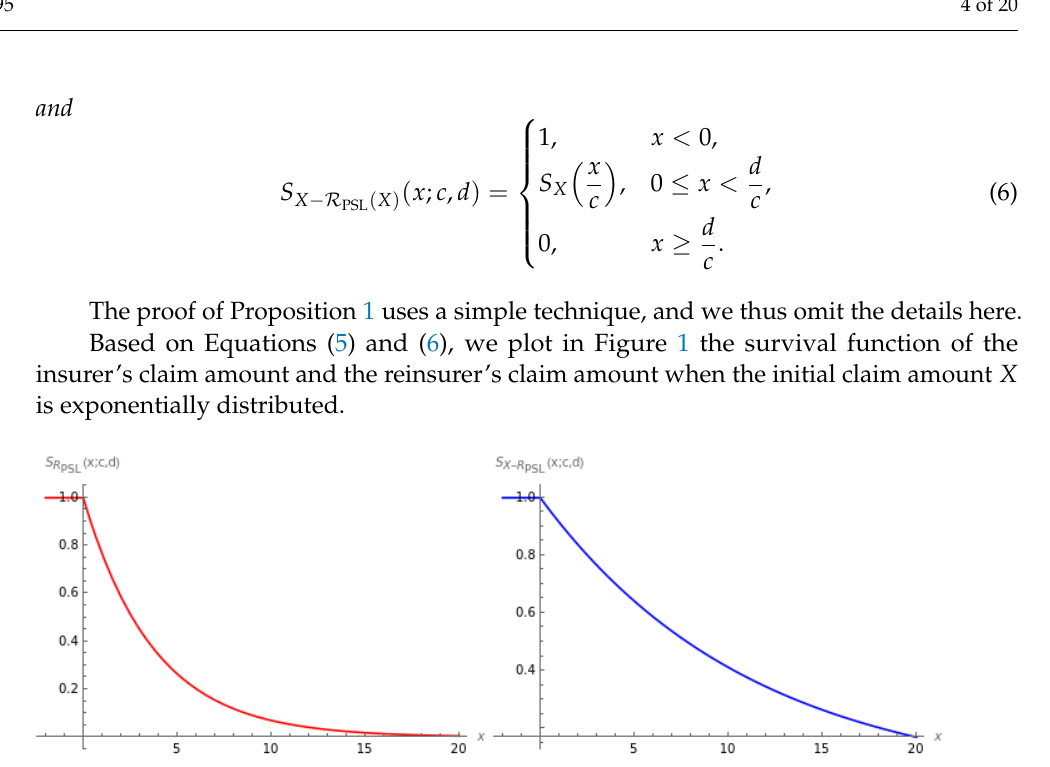
Figure 1. Graphical representation of the survival functions S R under a combination of proportional and stop-loss reinsurance with c = 75% and d = 20 when the initial claim amount X follows an exponential distribution ( λ =